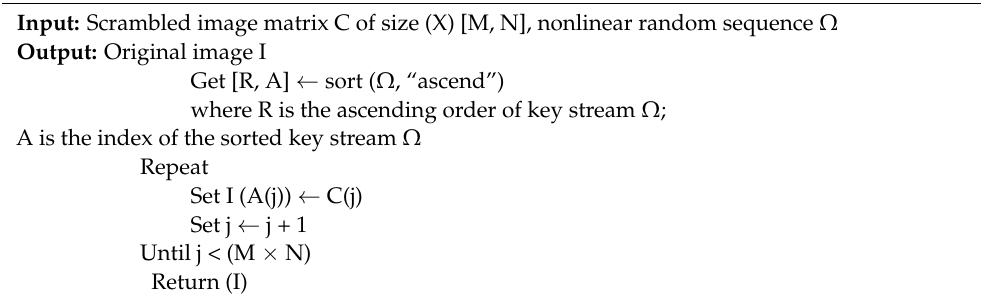
Algorithm 7: Image decryption—Hopfield-based